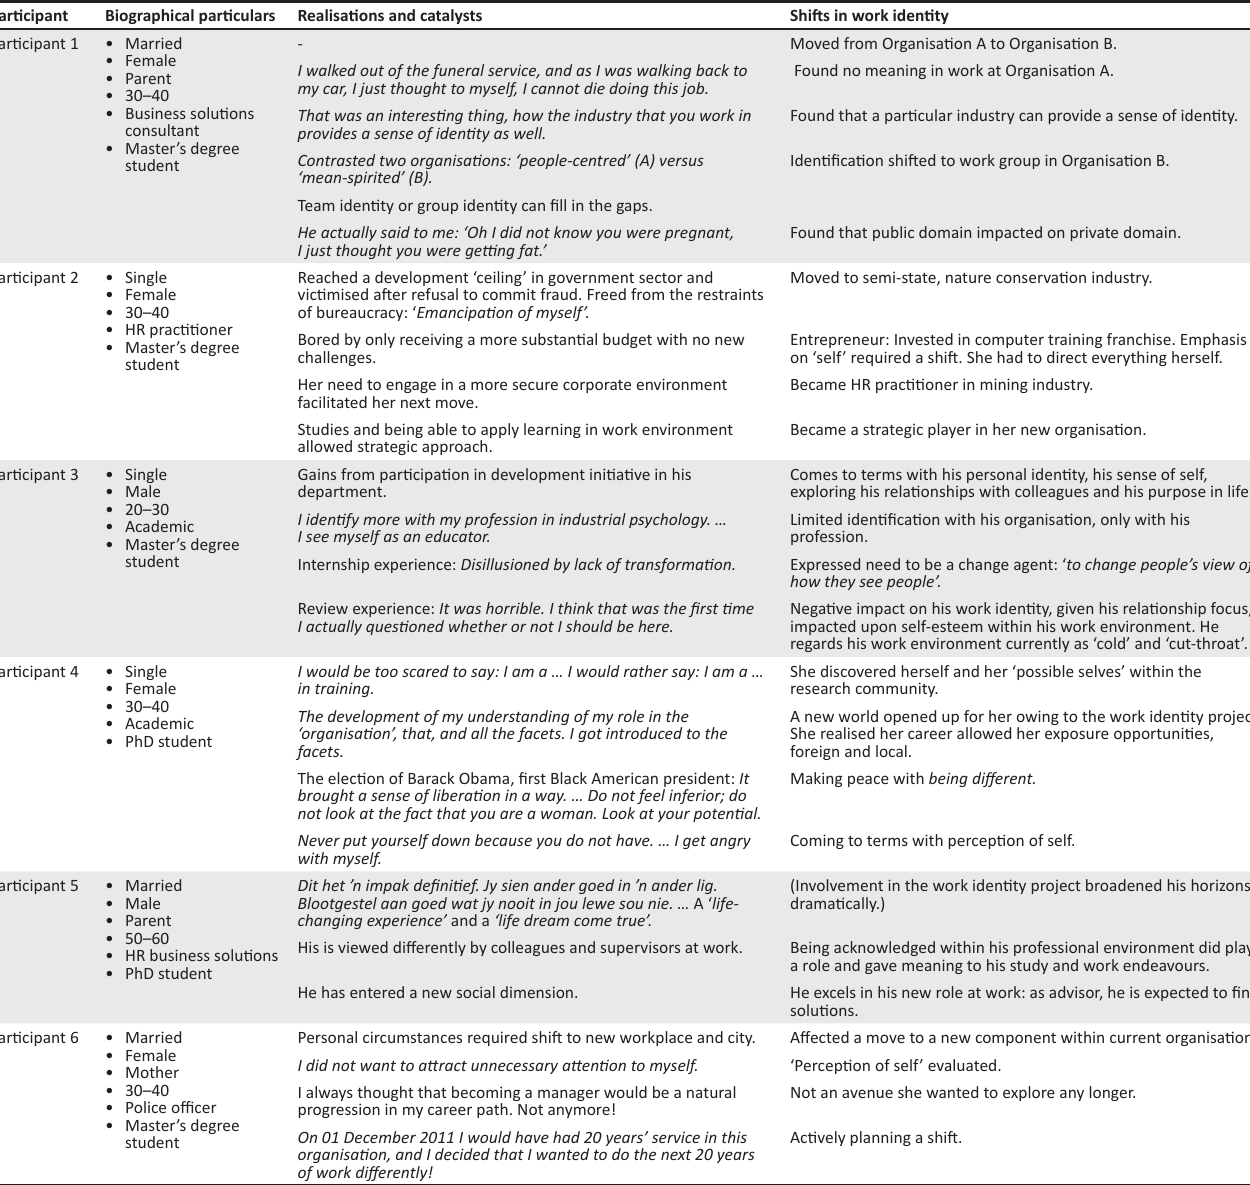
TABLE 1: Biographical particulars and contextualising participant stories and realisations or catalysts relating to shifts in work identity.